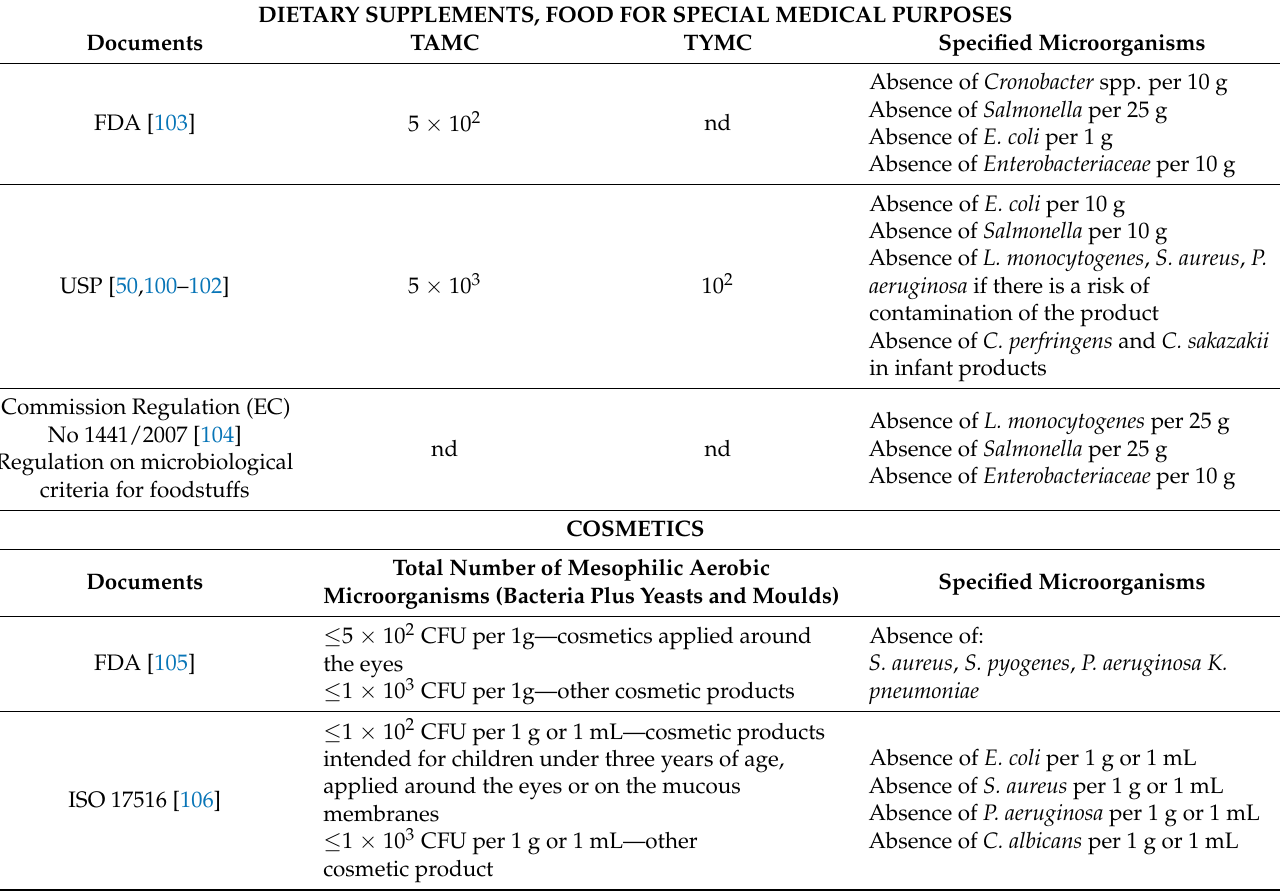
Acceptance criteria of dietary supplements [50,100–102], food for special medical purposes [103,104] and cosmetics